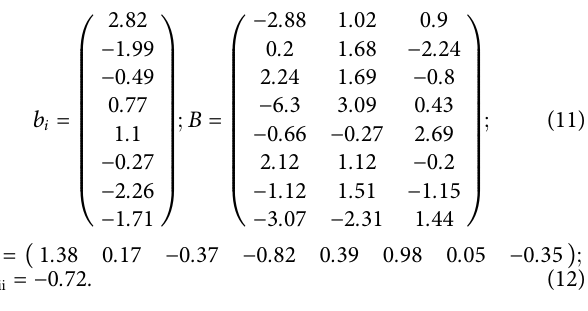
6, 8 and 10 neurons. The obtained mean squared errors are: 0.0265 for Levenberg-Marquardt with 6 neurons, 0.0306 for Levenberg-Marquardt with 8 neurons, 0.0377 for Quasi- Newton with 8 neurons, 0.0439 for Quasi-Newton with 10 neurons and 0.0364 for Fletcher-Powell with 10 neurons.